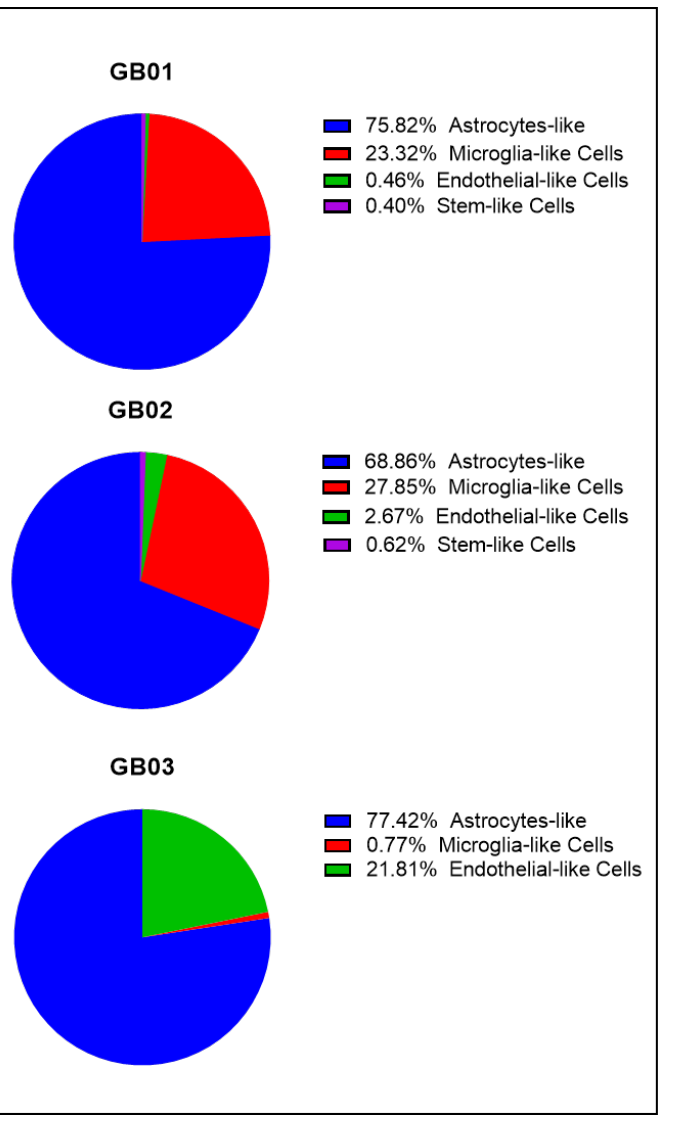
Figure 3. Pie charts of the percentages of the main cell type populations found in GB01, GB02, and GB03.